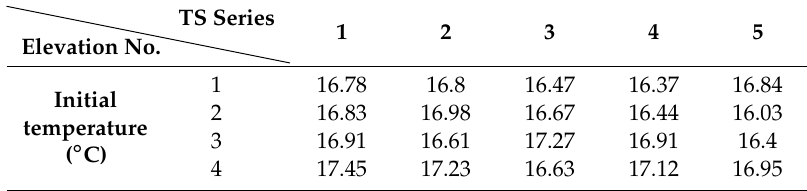
Table 4. Soil temperatures measured by TSs before circulation.